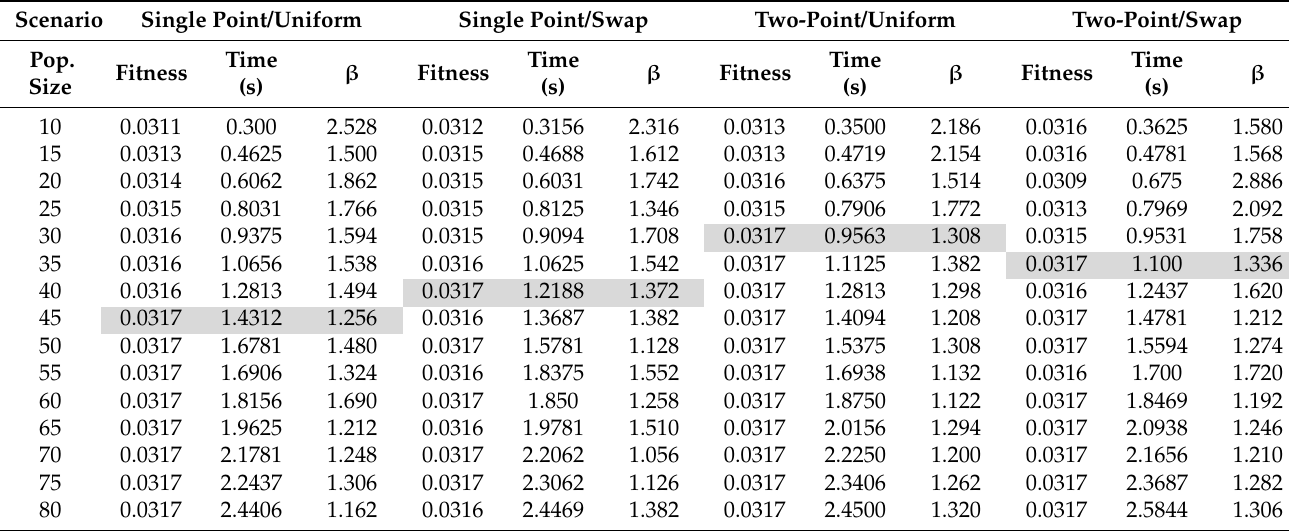
Table 1. The impact of population size on the GA accuracy. The best results are highlighted.